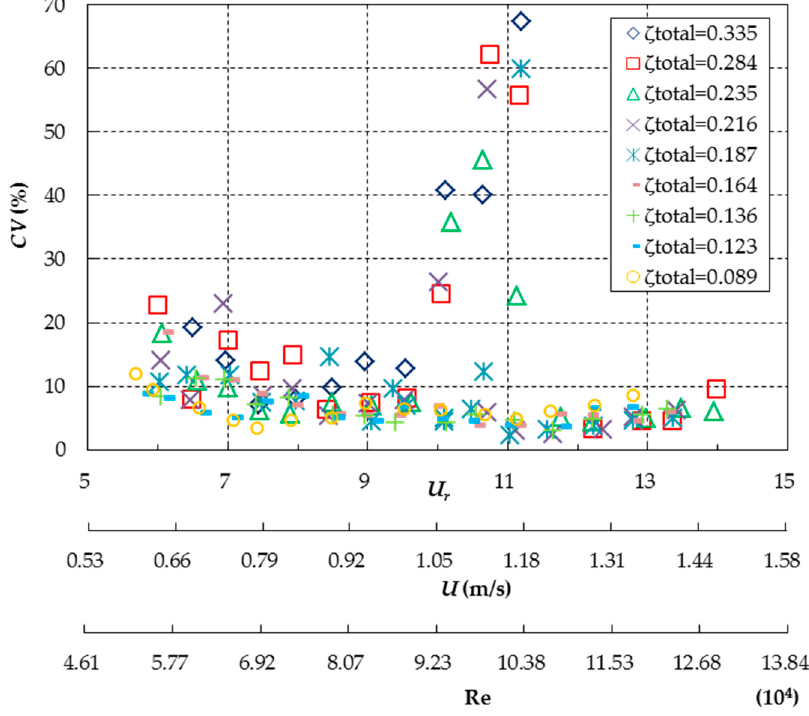
Figure 9. Amplitude variation coefficient CV A versus U r , U and Re for different ζ total .